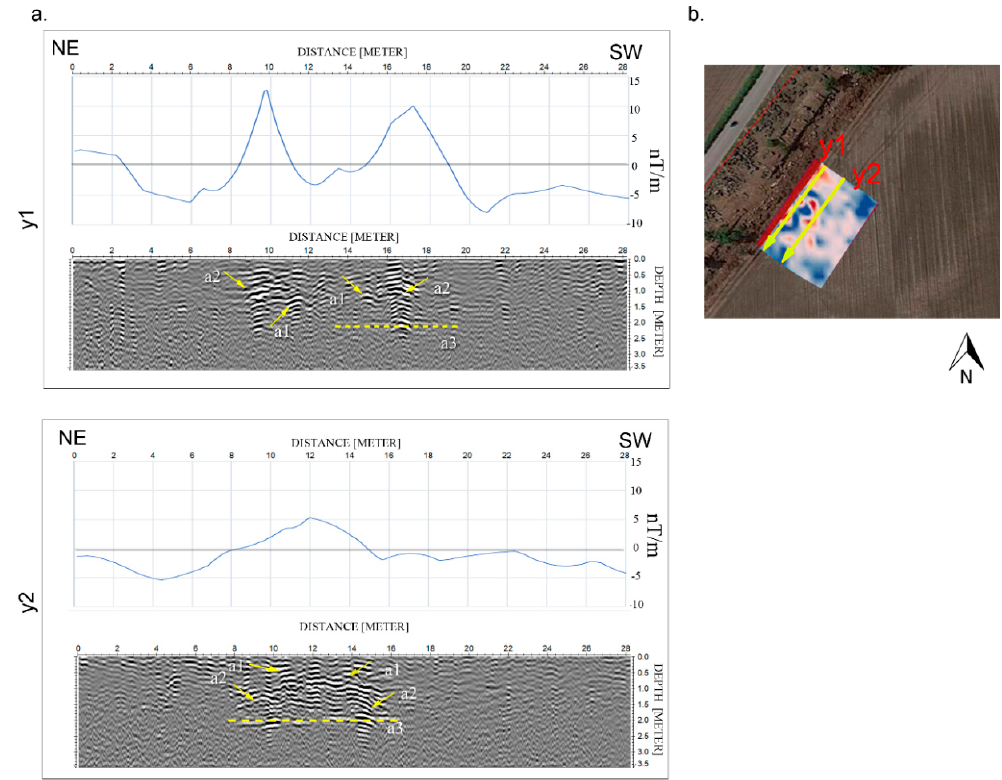
Figure 7. ( a ) Radargrams collected at the frequency of 200 MHz with their locations ( b ), compared with the MAG data along the same profiles. They are described in the text.